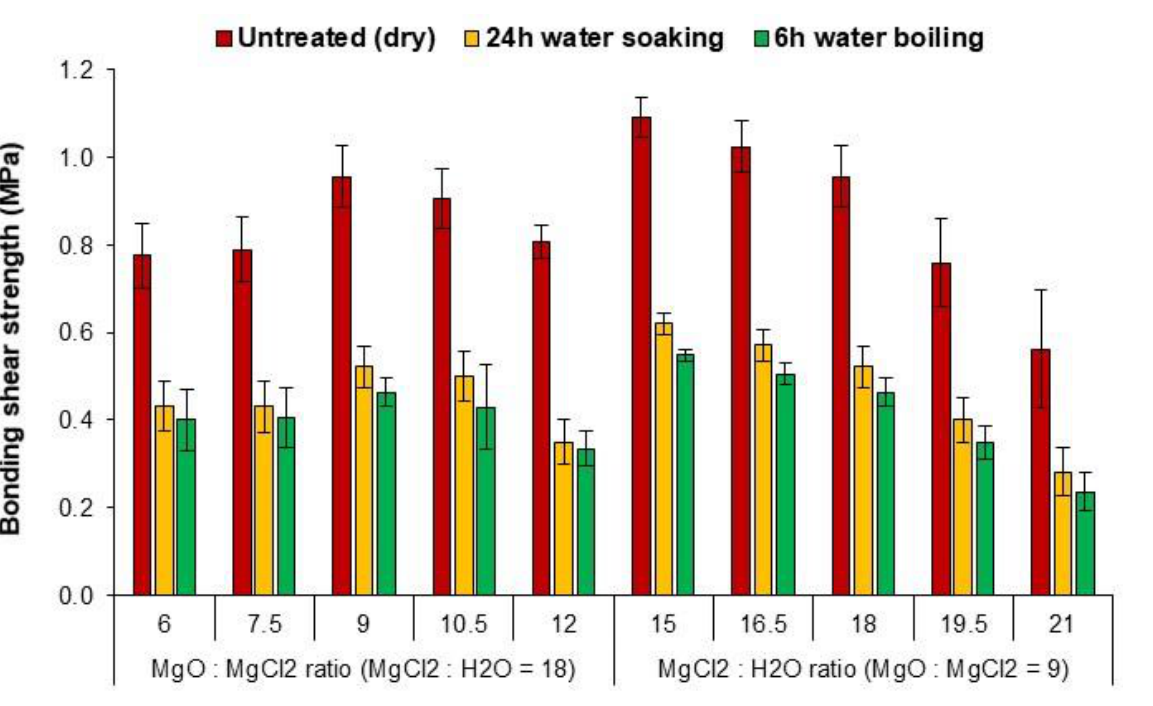
Figure 4. Shear strength of plywood samples using MOC binders with different molar ratios of the components.